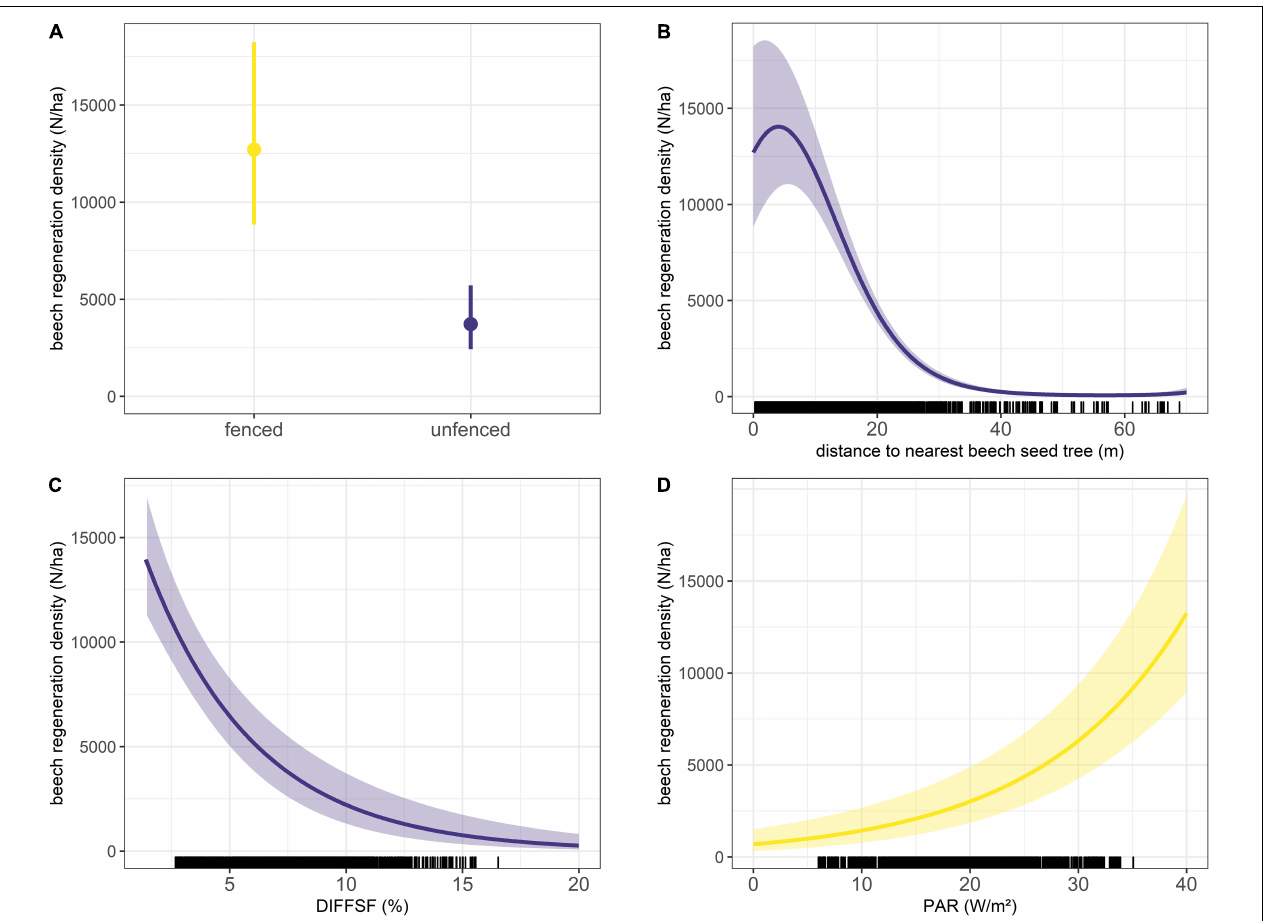
FIGURE 3 | Effect of significant covariates on beech natural regeneration density: (A) influence of the fence, (B) influence of the distance to the nearest beech seed tree, (C) influence of the proportion of diffuse radiation and (D) influence of photosynthetically active radiation. The transparent polygons for the continuous covariates and the error bars for the categorical covariates show the 95% confidence interval. All radiation variables were set to their mean; the factor fence was set on “fenced.” The distance to nearest seed tree was set 0. The figure also includes the representation of the raw data, i.e., beech regeneration that has been recorded at different distances and radiation